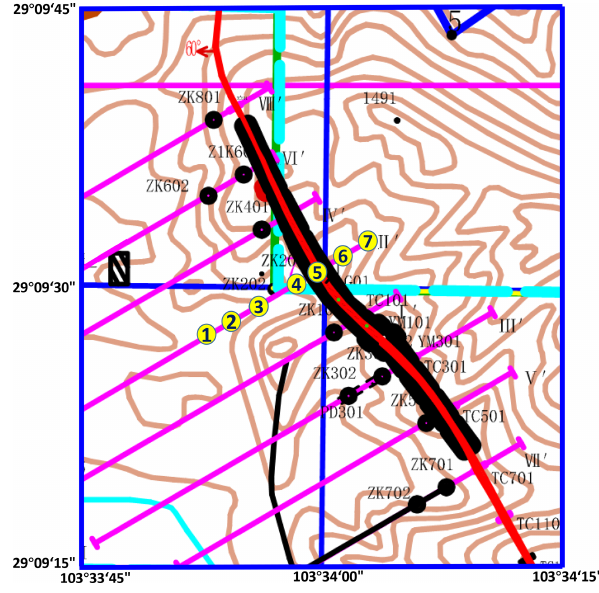
Figure 11. The geographic distribution of the collection points (first to